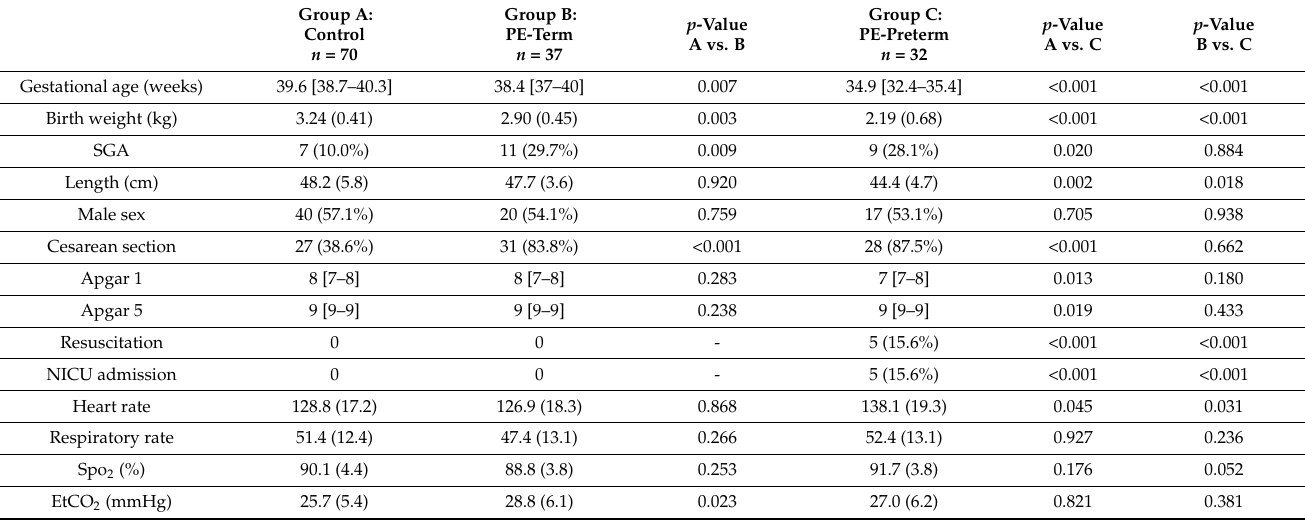
Table 1. Characteristics and vital parameters of the included